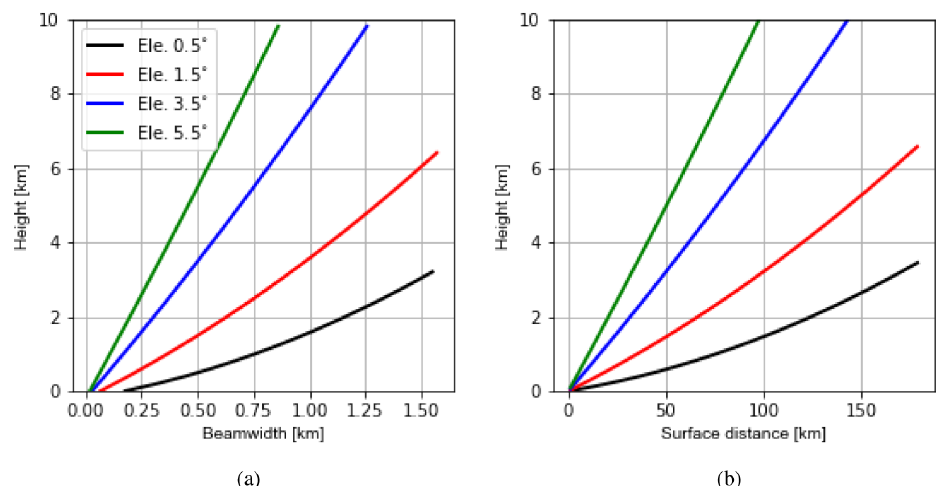
Figure 2. Illustration of variations of beamwidths (in km for azimuth resolution of 1 . 0 ◦ ) with height (a) and surface distances (away from the radar station) with corresponding heights (b) for elevations of 0 . 5, 1 . 5, 3 . 5 and 5 . 5 ◦ , based on the 4 / 3 Earth radius model. The height of the radar station is omitted. The figure for radial ranges with corresponding heights looks very similar to the right